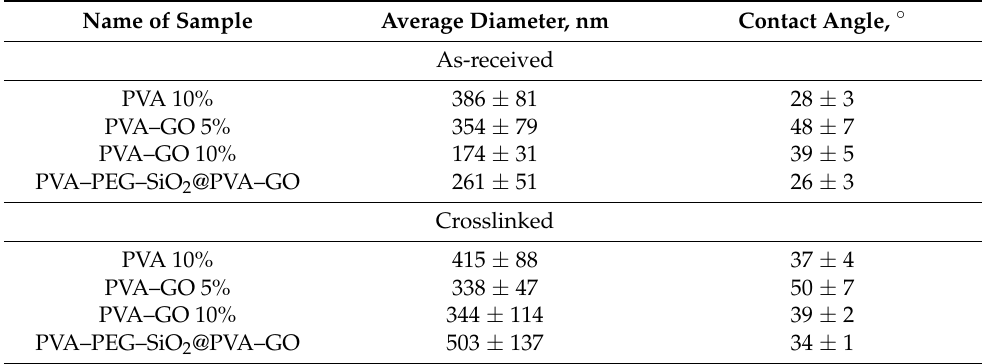
Table 3. The contact angle of PVA–GO 5%, PVA–GO 10%, and PVA–PEG–SiO 2 @PVA–GO before and after crosslinking.